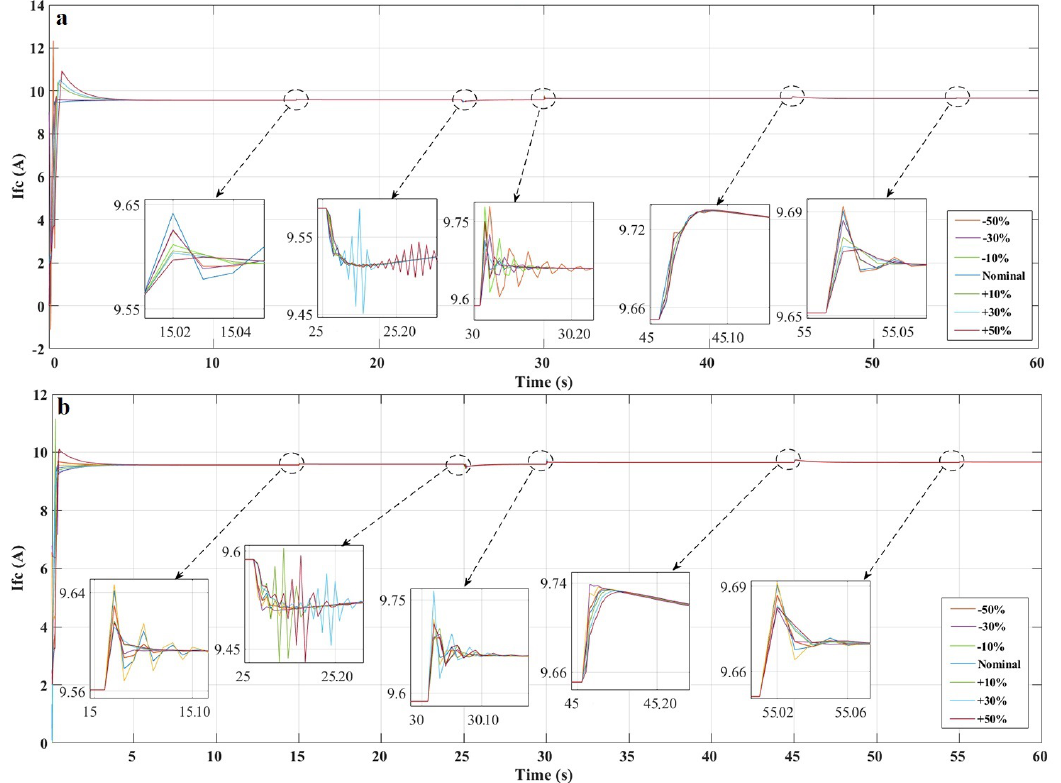
Figure 14. ( a ) PEMFC current control robustness analysis: effect of L variation; ( b ) PEMFC current control robustness analysis: effect of C